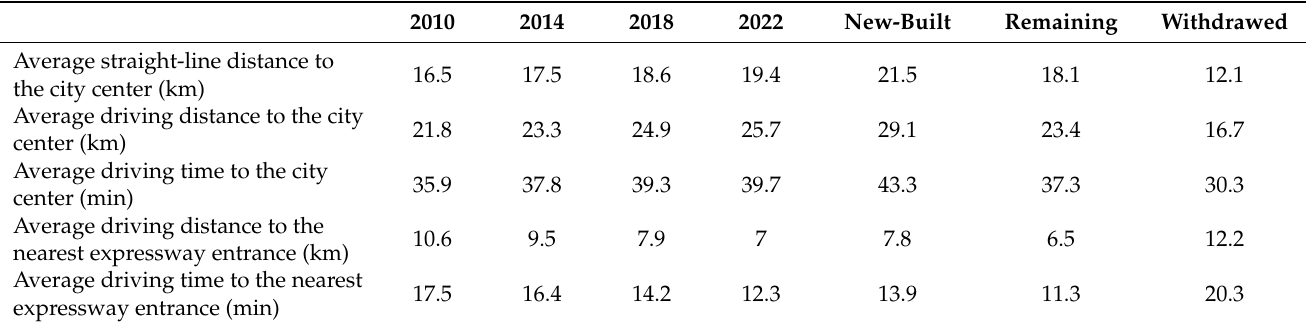
Figure 5. The proportion of ports more than 20 km away from the city center, less than 10 km away from nearest expressway entrance, and the nearest expressway entrance shared with cities. ( a ) the proportion of ports in different years and different states more than 20 km away from the city center, ( b ) the proportion of ports in different years and different states less than 10 km away from nearest expressway entrance, ( c ) the proportion of nearest expressway entrance shared by ports and cities. Table 1. The distance between the container ports and the city center and the nearest expressway